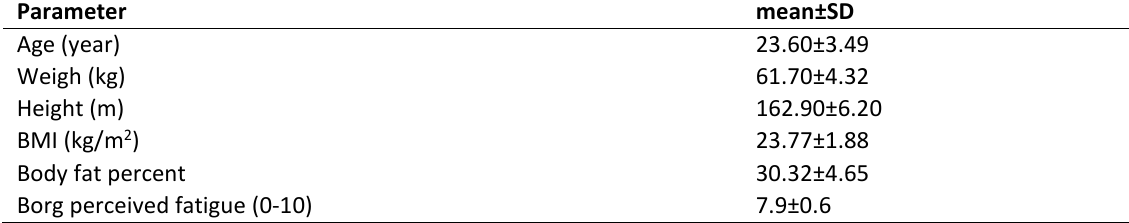
Table1. Participant characteristics (n=20).